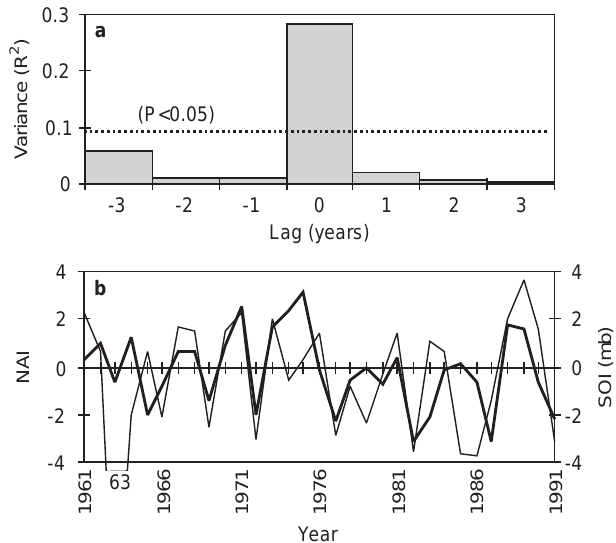
Fig. 2. a Results of a lag correlation analysis (omitting data for 1963 and 1989) showing the variance in the mean annual SOI explained by the NAI, when the latter index led or lagged the SOI by up to 3 years; b Superimposed time series of the NAI ( light line ) (the 1963 value of ) 12 being o(cid:128) scale), and the mean annual SOI ( heavy line )